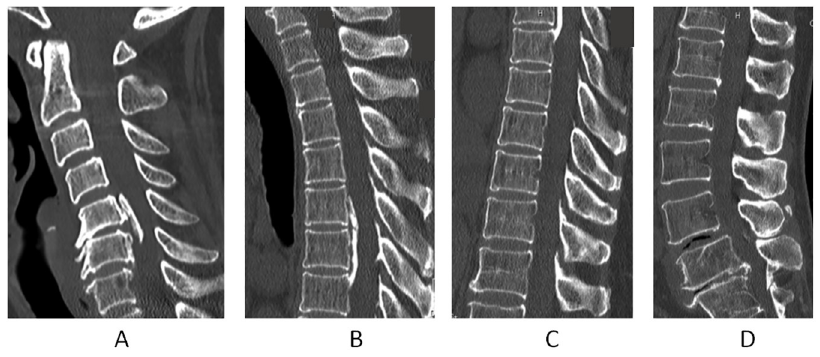
Fig 1. CT images of a patient with ossification of the posterior longitudinal ligament (OPLL). This 60-year-old female has OPLL at C5, 5–6, 6 (A), T5, 5–6, 6 6–7,7 (B, C) L1-2 and L5-S1 (D). Her OS index is 9.